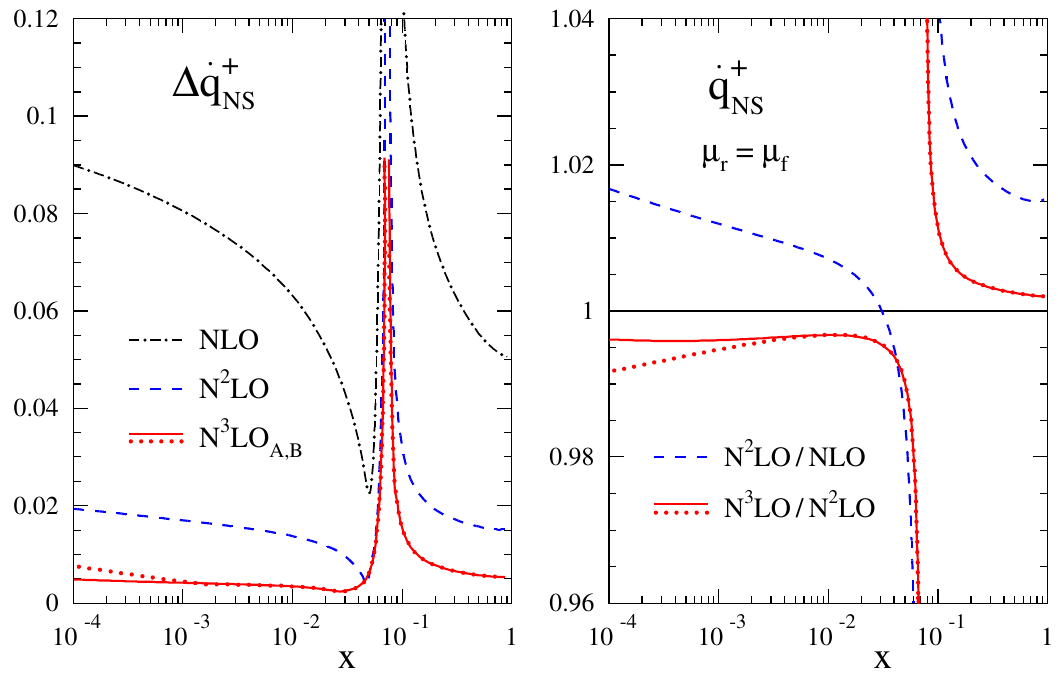
Figure 10 . Left panel: the (cid:22) r -uncertainty of the NLO, N 2 LO and N 3 LO results for the scale derivative of q + as obtained from the quantity (cid:1) _ q i ns and N 3 LO corrections to the logarithmic scale derivative of q + quark distribution (5.6) at (cid:22) r = (cid:22) f